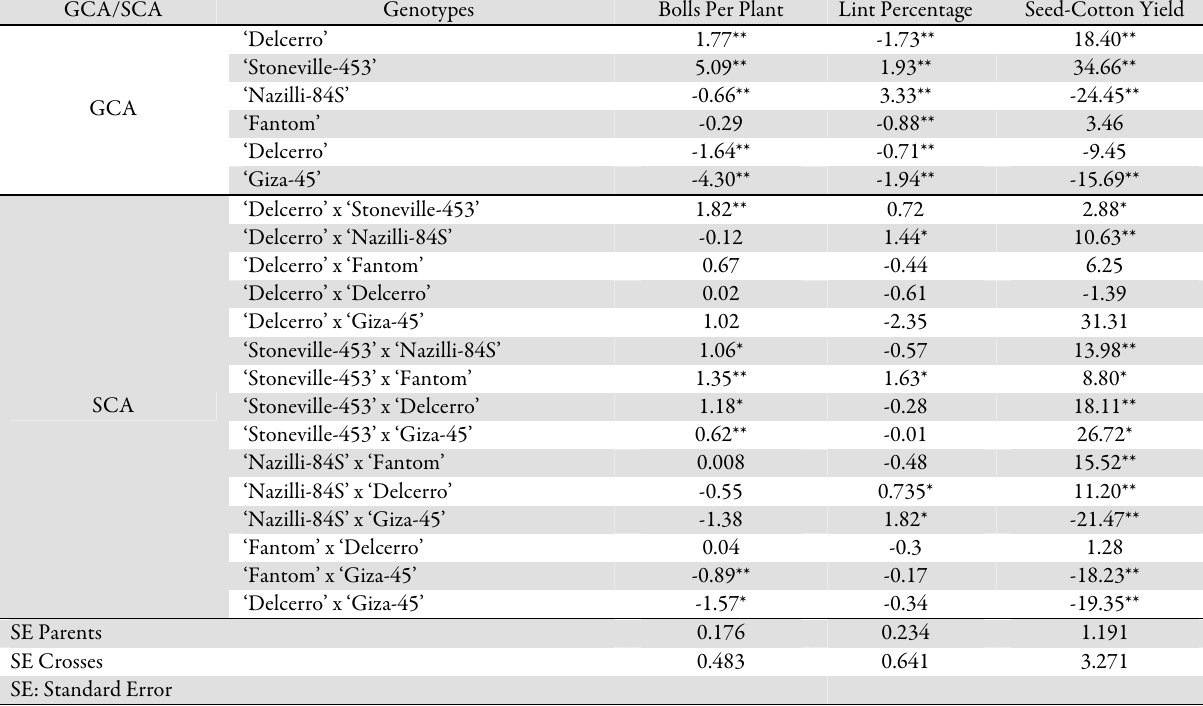
Table 3. GCA for the investigated traits in cotton parents and SCA for the investigated traits in cotton F 1 diallel crosses GCA/SCA